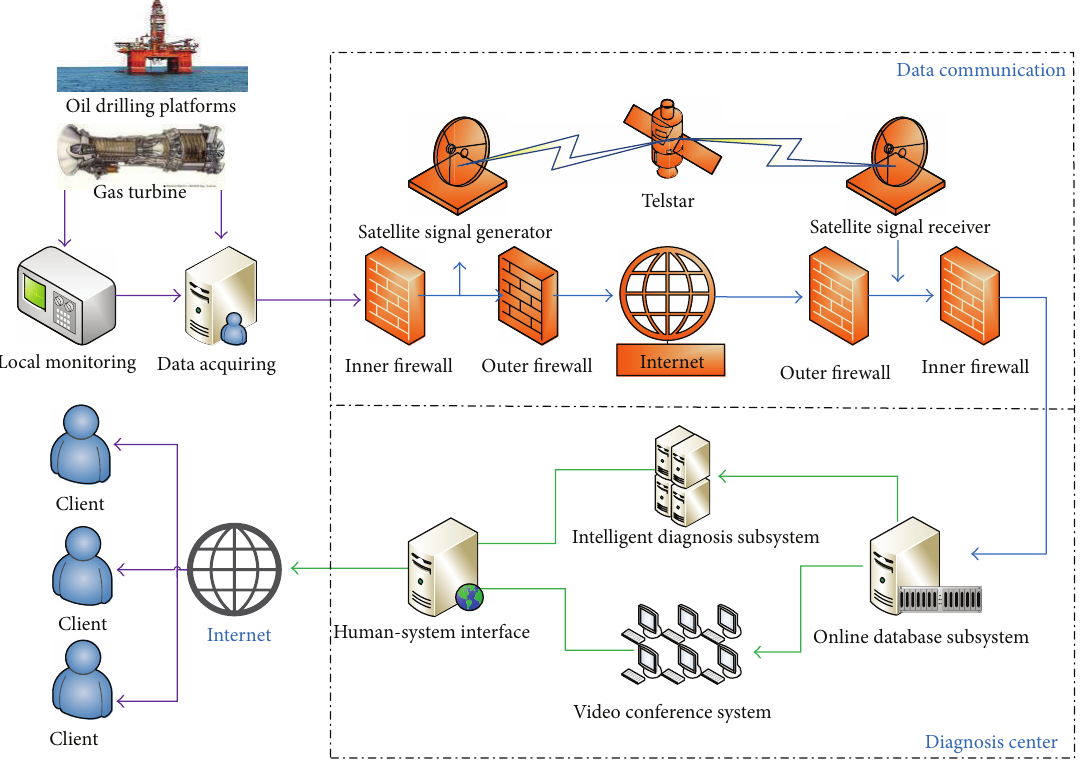
Figure 2: Structure of the remote system of condition monitoring and fault analysis.